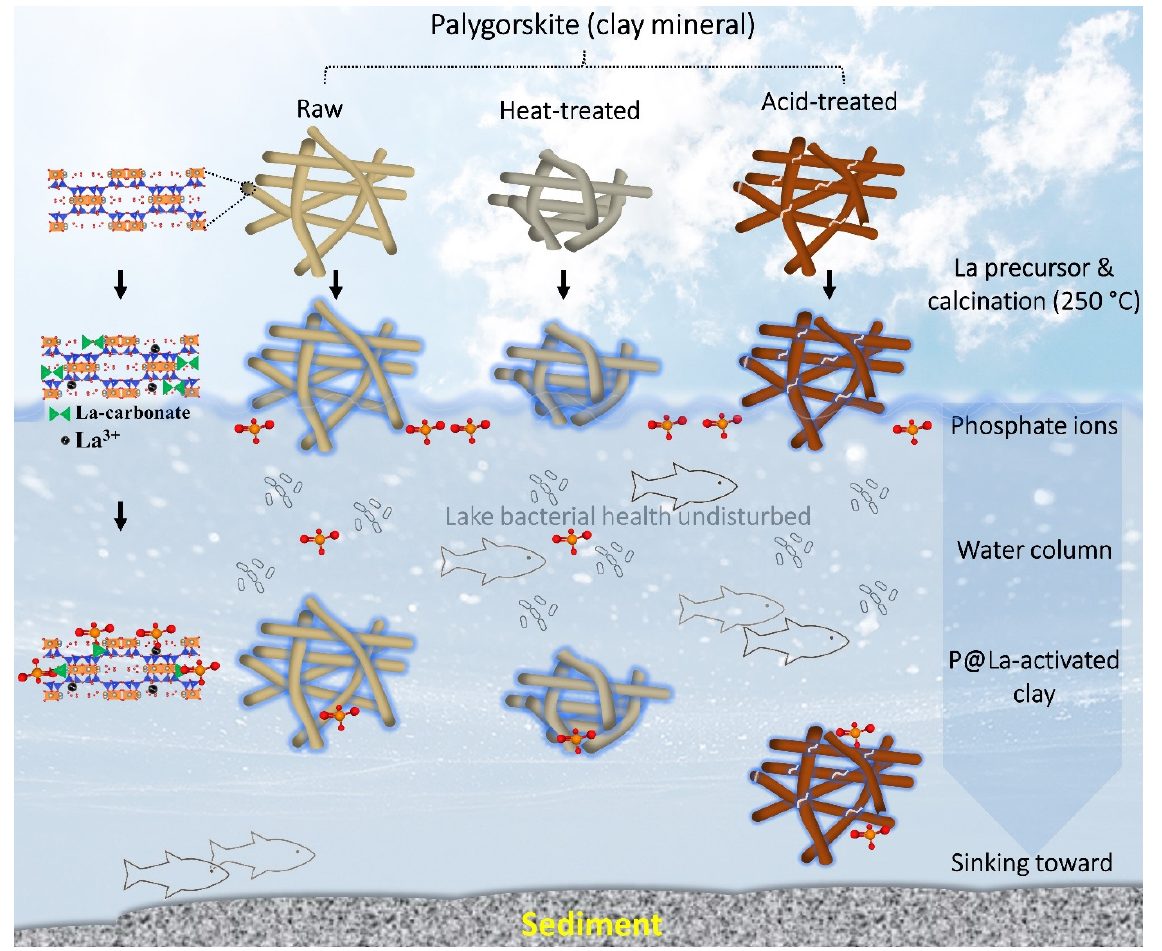
Figure 9. The overall modus operandi of the modified palygorskite in the lake water to remove phosphorus from surface water of the affected lake. The cartoon shows that La modified acid-treated palygorskite was efficient to adsorb P while travelling down to the bottom of the lake without impacting microbial health in the water column.